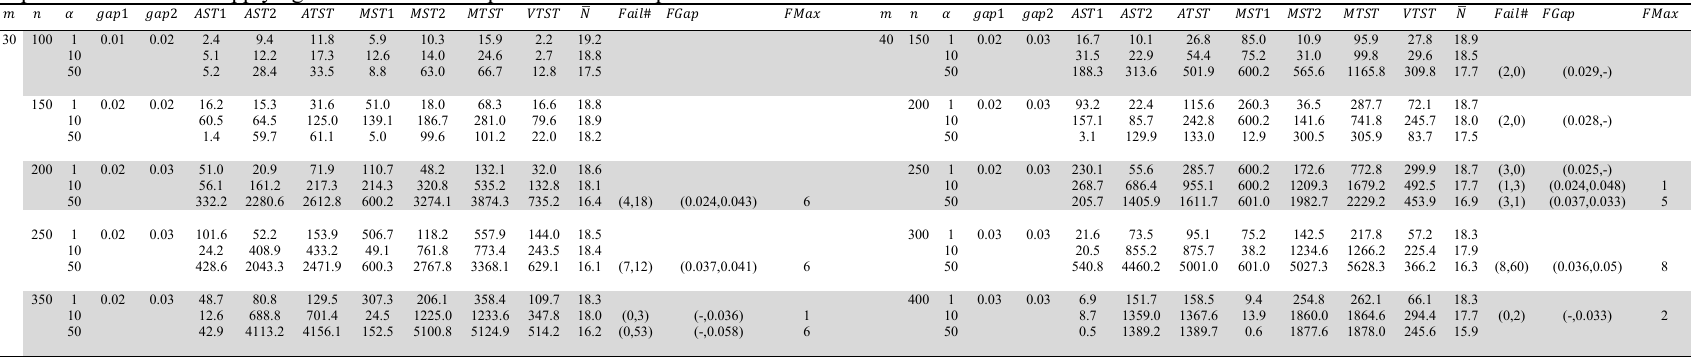
Experimental results of applying the MILP solution procedure for the problem instances with 30 and 40 machines 𝑚 𝑛 𝛼 𝑔𝑎𝑝 1 𝑔𝑎𝑝 2 𝐴𝑆𝑇 1 𝐴𝑆𝑇 2 𝐴𝑇𝑆𝑇 𝑀𝑆𝑇 1 𝑀𝑆𝑇 2 𝑀𝑇𝑆𝑇 𝑉𝑇𝑆𝑇 𝑁(cid:3365)